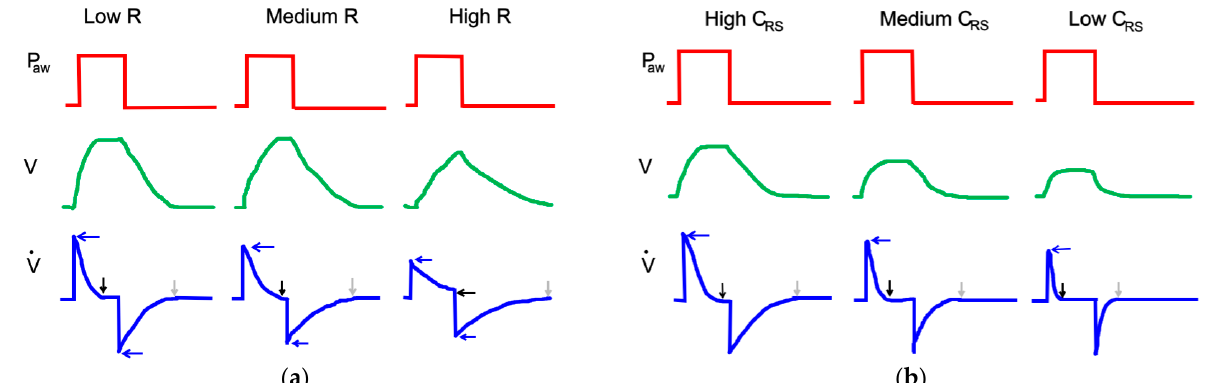
Figure 9. Effect of the increase in airway resistance ( a ) and decrease in lung compliance ( b ) during PC − CMV mode, adapted from [45].